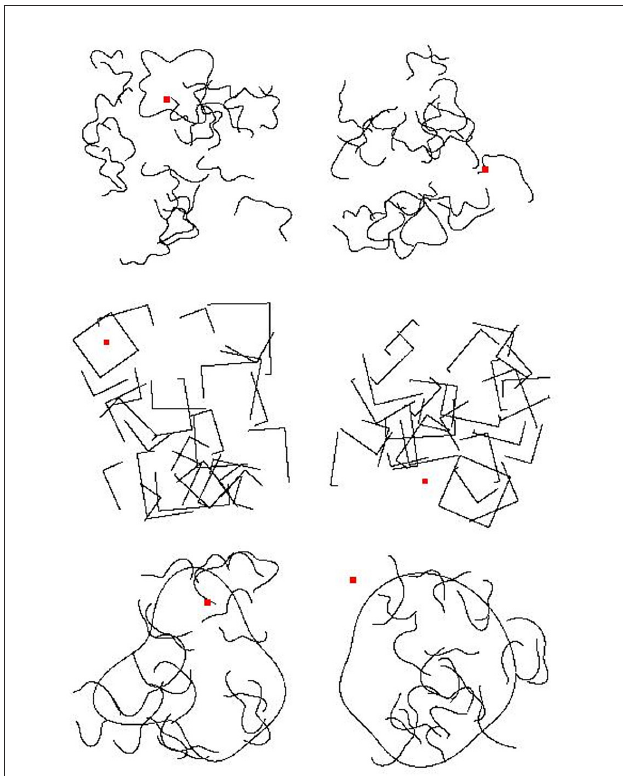
FIGURE5 Example generalization test images for Experiment 2b. (Top) An “Inside” and an “Outside” image for the first generalization test. (Middle) An “Inside” and an “Outside” image from the second generalization test. (Bottom) An “Inside” and an “Outside” image for the third generalization test. Category membership was determined by the position of the small, red square, either inside or outside of a closed